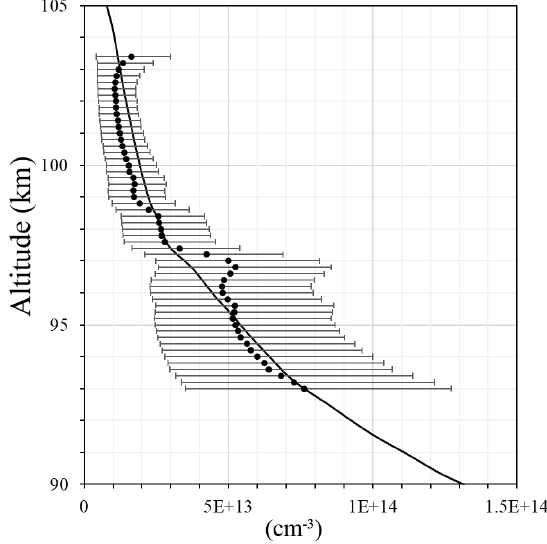
Figure 3. RHS (dots) and least-squares fit of LHS (black line) of Eq. (4).